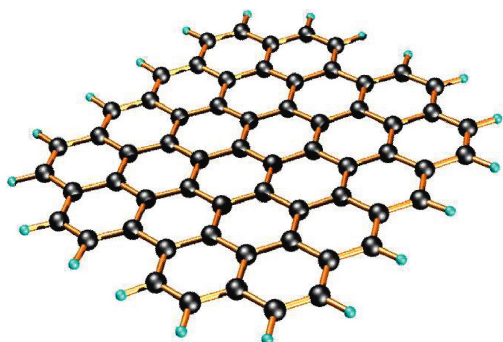
Figure 1: The structure of graphene.